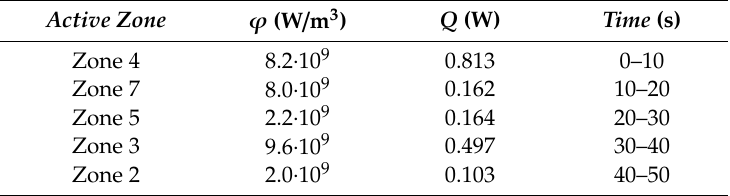
Table 8. Activation of the di ff erent zones of the chip for transient simulation number 1.